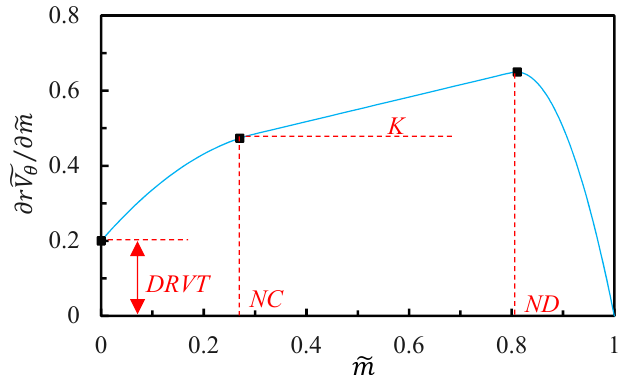
Figure 6. Blade loading distribution along the streamline.